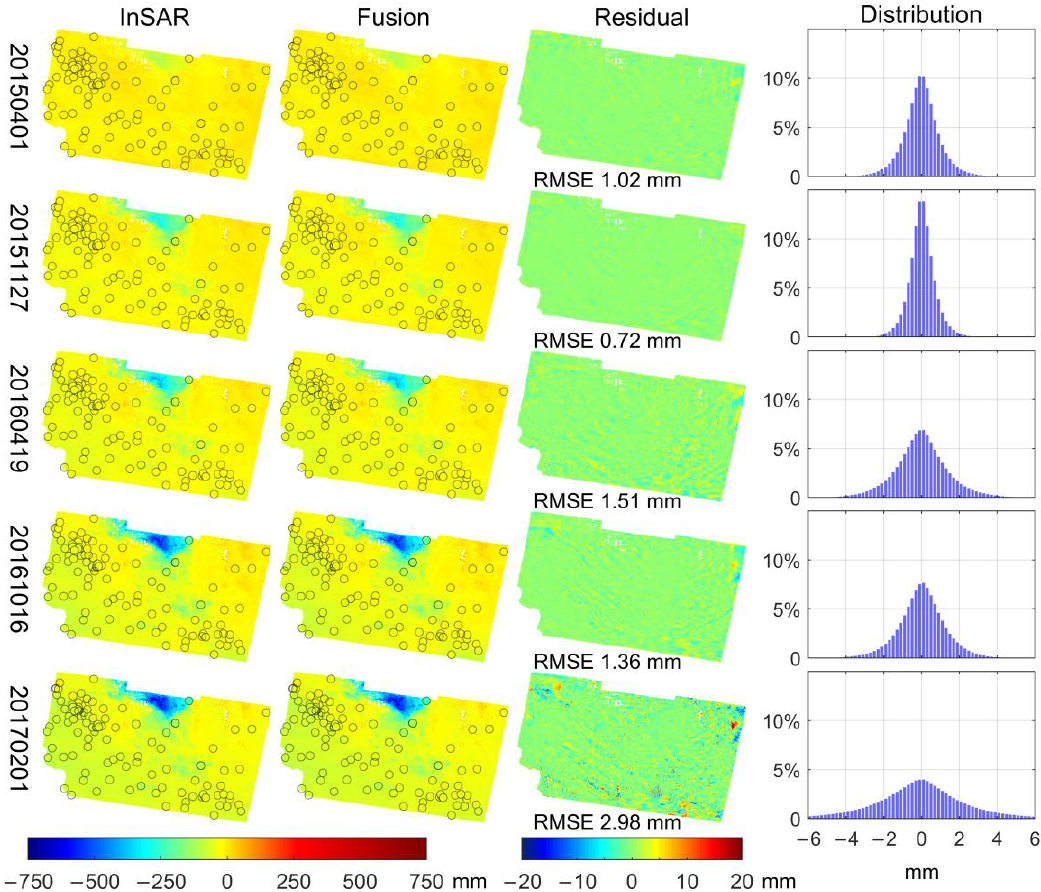
Figure 6. Leave-one-out cross-validation results and residuals corresponding to five periods of interferometric synthetic aperture radar (InSAR) data; each row represents one period of data. The first column represents InSAR observation data, second column represents results of fusion, third column represents residuals, and fourth column represents the histogram of residuals. Warm colors (i.e., positive values) indicate surface displacement toward the satellite, and cold colors (i.e., negative values) indicate motion away from the satellite. Circles represent locations of global navigation satellite system sites, and filled colors represent the deformation values.